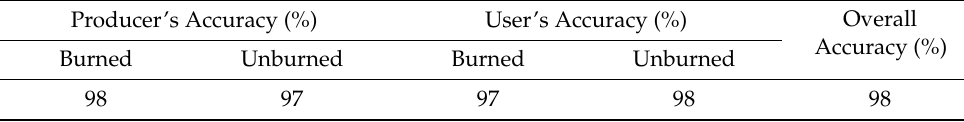
Table 4. Accuracy assessments for burned and unburned